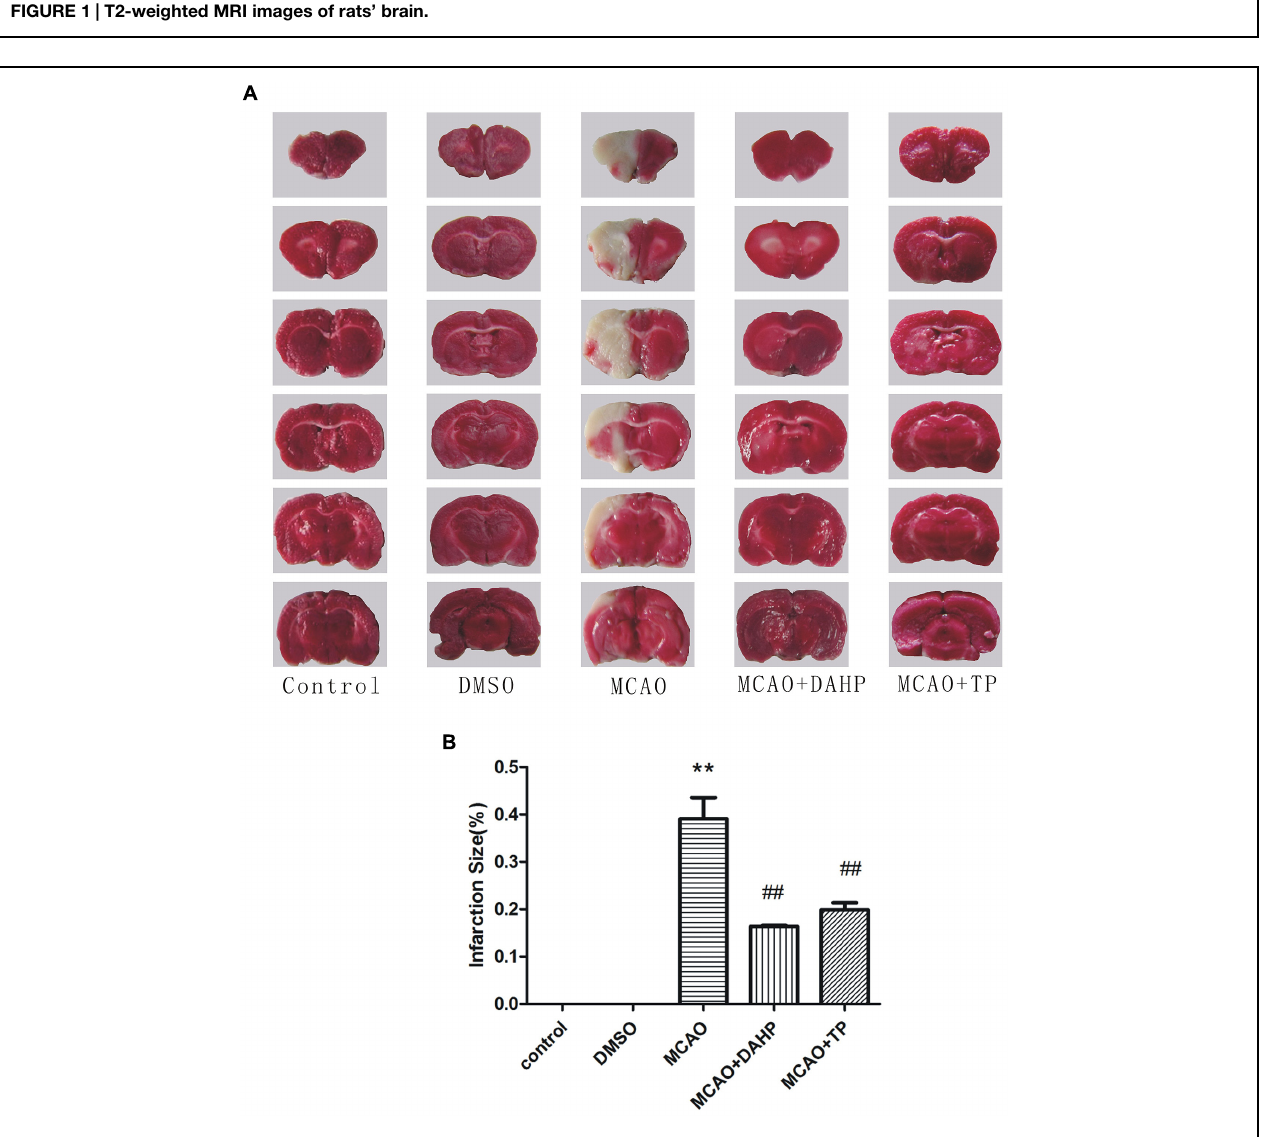
was expressed as the percentage of the contra lateral hemispheric area. Infarction size was then analyzed using Meta-Morph program. Data were expressed as mean ± SD, ∗∗ P < 0.01 vs. control group; ## P < 0.01 vs. MCAO group.